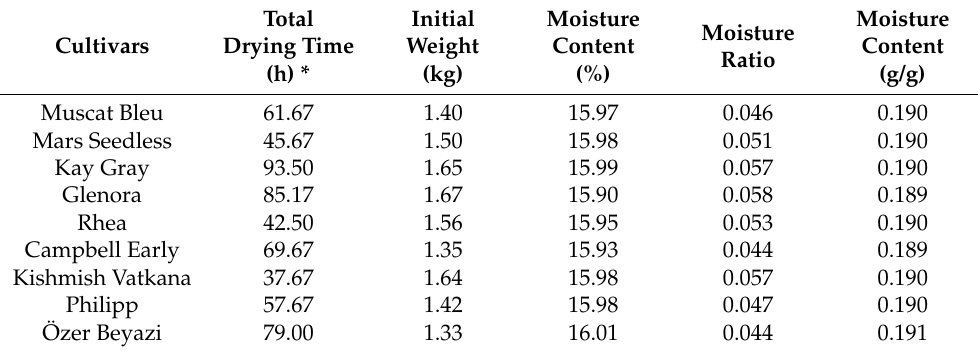
Table 2. Initial weight of fresh berries and final moisture values of their raisins after drying in an air-pump